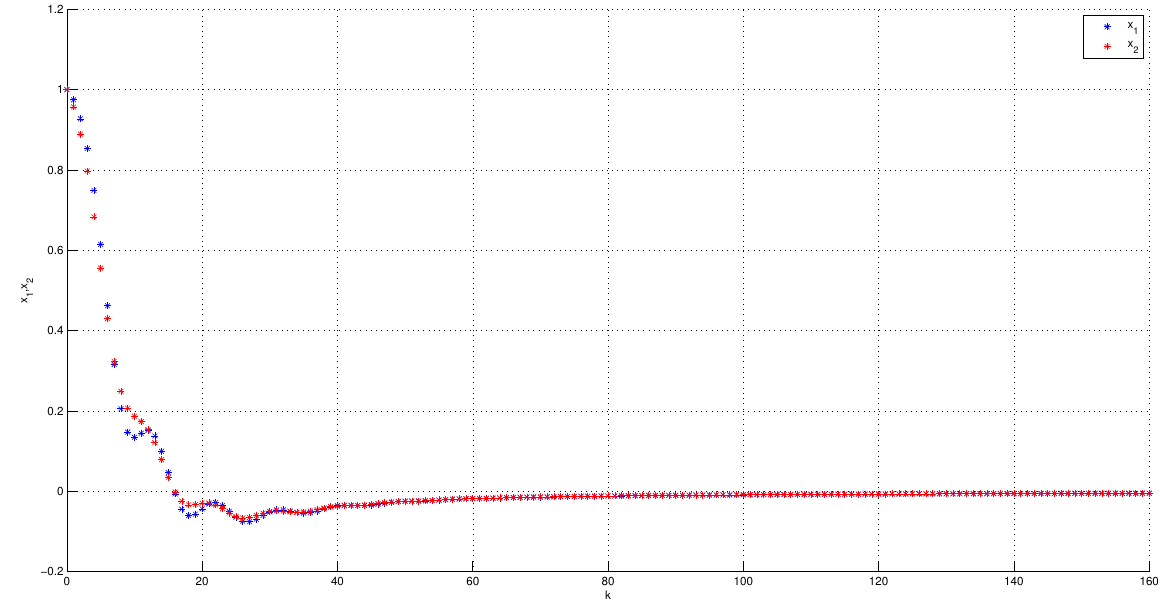
Figure 1. The stability of the trivial solution of system (26) with x 1 ( 0 ) = x 2 ( 0 ) = 1. Herein, M = 6 and so   det